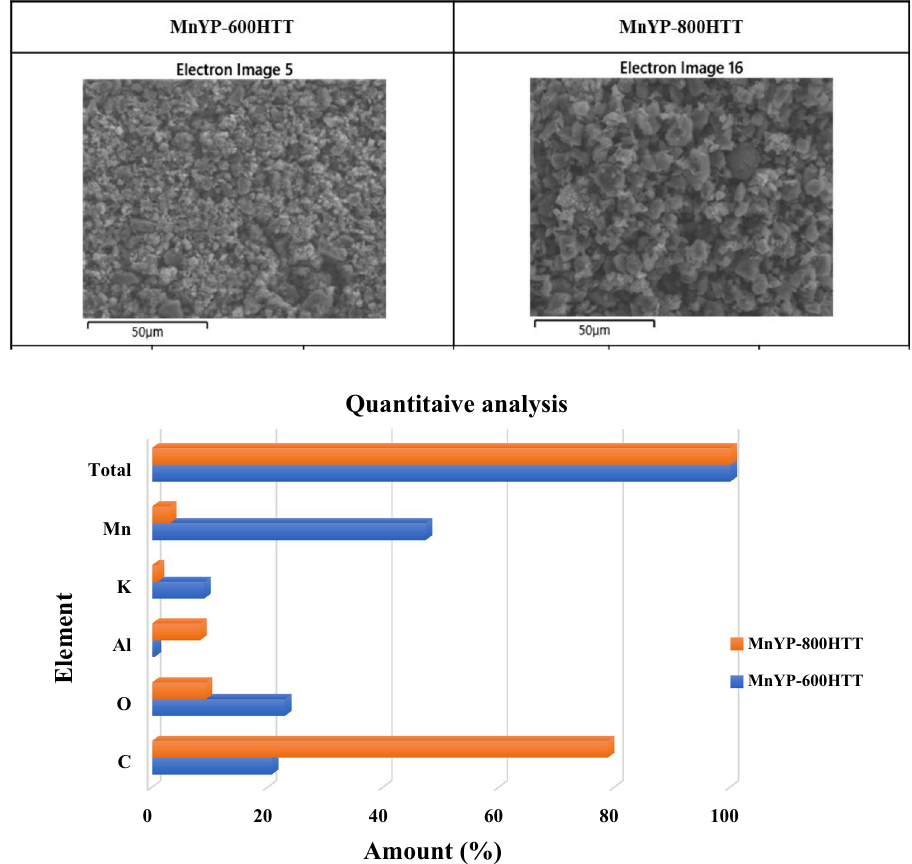
Figure 3. The quantitative analysis results.